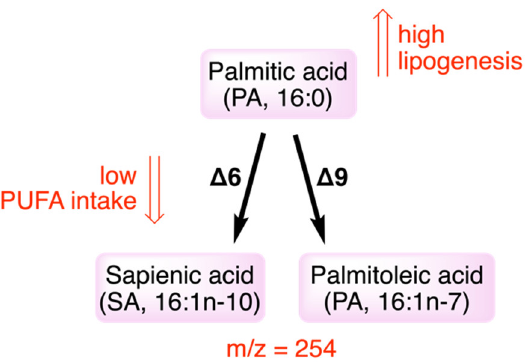
Figure 2. Palmitic acid transformations by delta-9 and delta-6 desaturase enzymes. Positional isomers formation from delta-9 and delta-6 desaturase activities on palmitic acid: sapienic acid has the same molecular mass of palmitoleic acid (m/z = 254 or their methyl esters m/z = 268). For low PUFA intakes, delta-6 desaturase can enter in the transformation of palmitic acid to sapienic acid which is a n-10 fatty acid not belonging to the usual metabolism of saturated fatty acids.